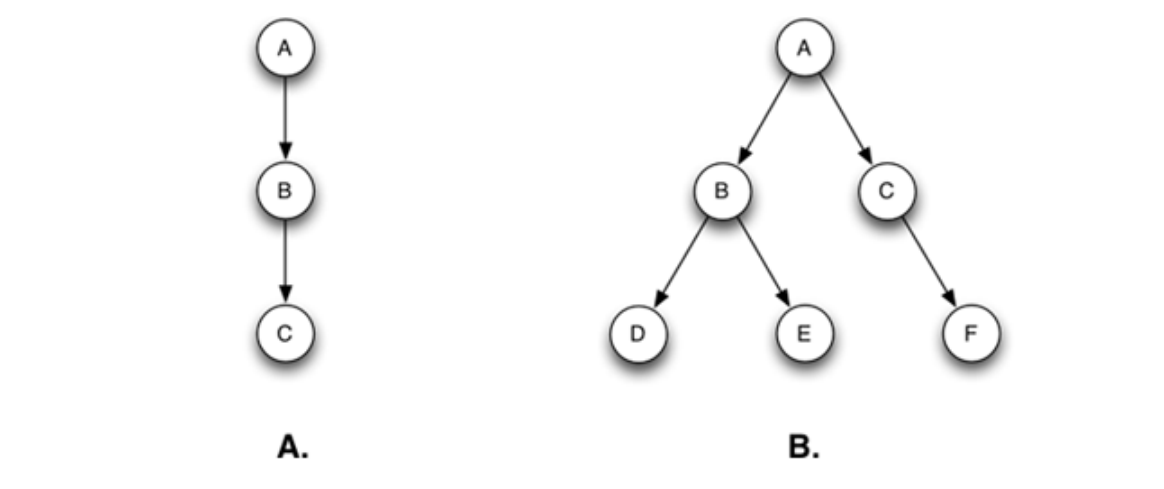
Fig. 4. A network model of social hierarchy (adapted with permission from Krackhardt 1994, Fig.